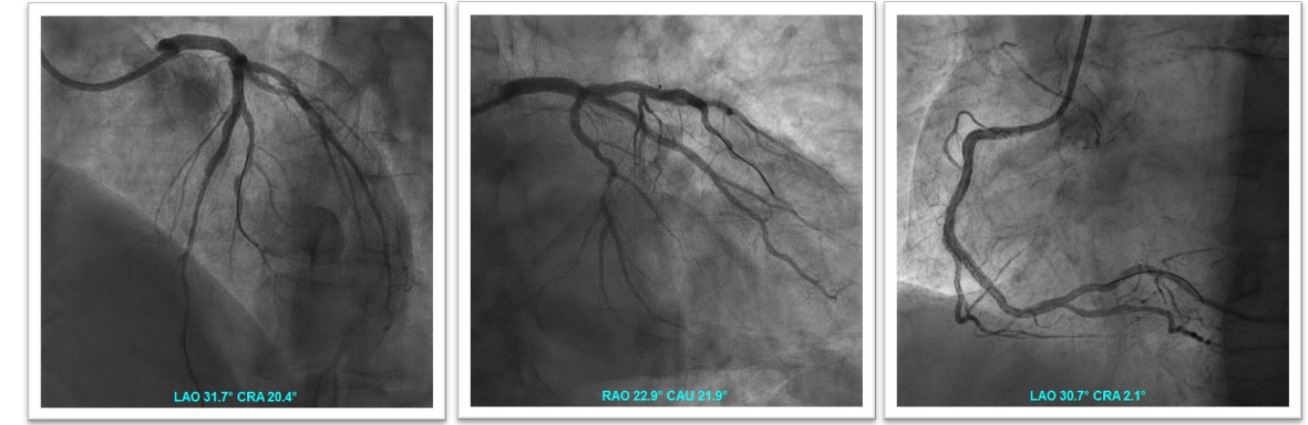
Figure 5. Coronary angiogram revealing the patency of previously implanted stents.